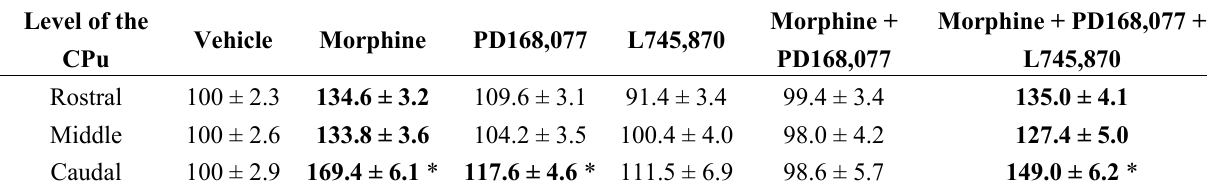
Table 1. Effect of six days of continuous treatment with morphine (20 mg/kg/day), PD168,077 (1 mg/kg/day) and L745,870 (1 mg/kg/day) alone or combined on mu opioid receptor (MOR) immunoreactivity (IR) in the striosomes throughout the rostro-caudal axis of the rat